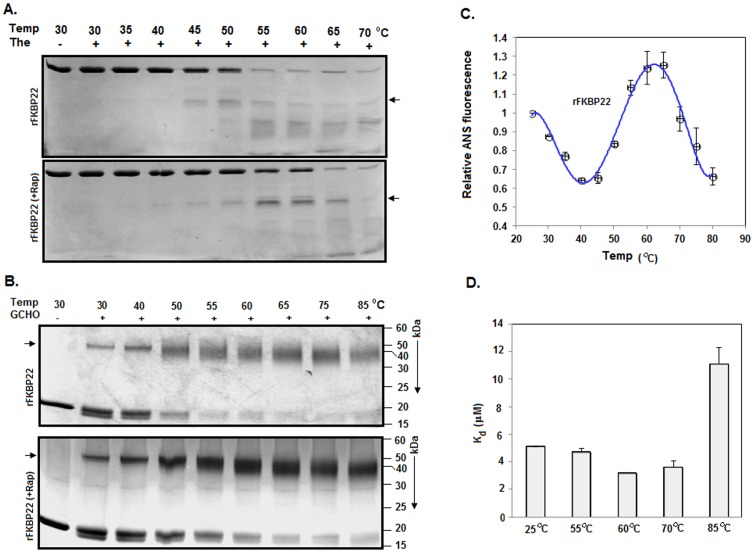
Characterization of the intermediates.(A) SDS-13.5% PAGE analysis of the fragments obtained from partial proteolysis of rFKBP22 (attached with or without rapamycin) with thermolysin (The) at 30°–70°C. Arrow indicates the additional protein fragments produced during proteolysis. (B) Chemical cross-linking. Proteins generated from glutaraldehyde (GCHO)-mediated cross-linking of rFKBP22 (attached with or without rFKBP22) at 30°–70°C were analyzed by SDS-13.5% PAGE. Arrow indicates dimeric rFKBP22 (attached with or without rapamycin). (C) ANS fluorescence of rFKBP22 at different temperatures. (D) Determination of K
d values for rapamycin-rFKBP22 interactions at different temperatures.